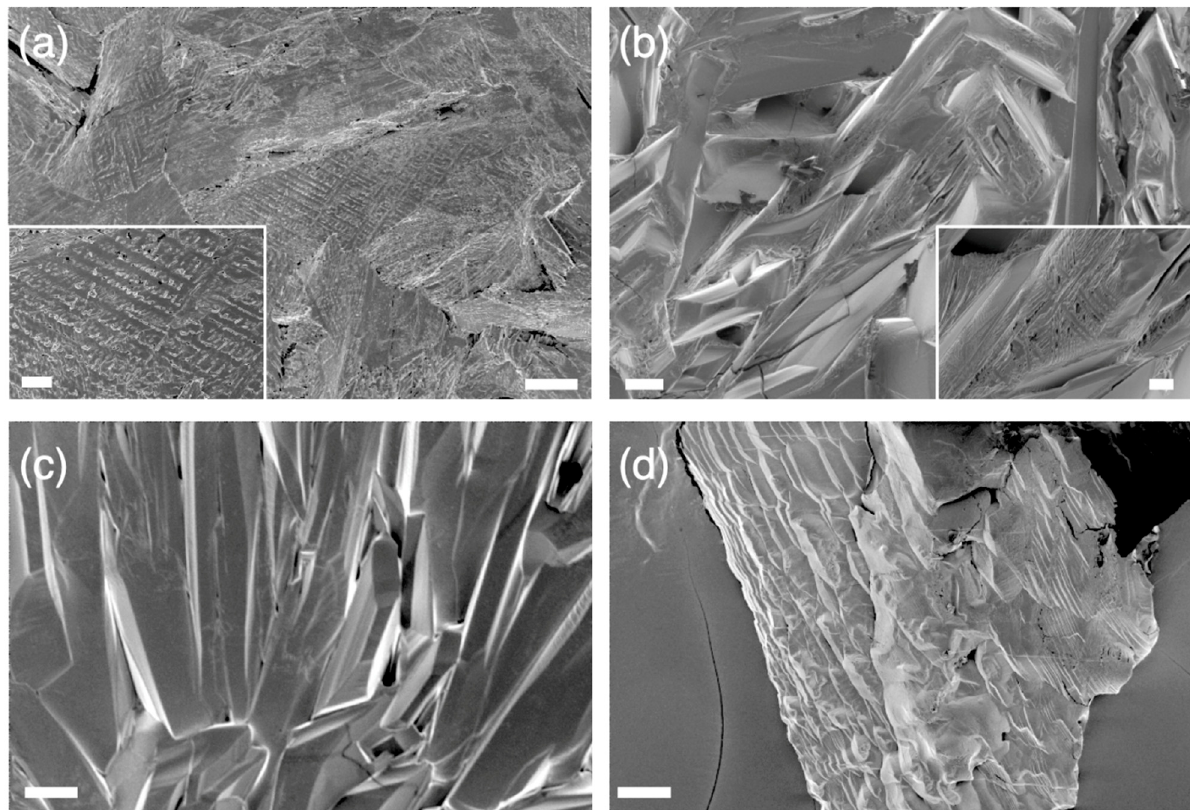
Figure 4. SEM images of NPX/SUB mixtures and neat phases after melt recrystallization: ( a ) 4.8:5.2 (eutectic); ( b ) 8:2; ( c ) neat NPX; ( d ) neat SUB. Scale bars in the main images and insets are 20 μ m and 5 μ m, respectively.